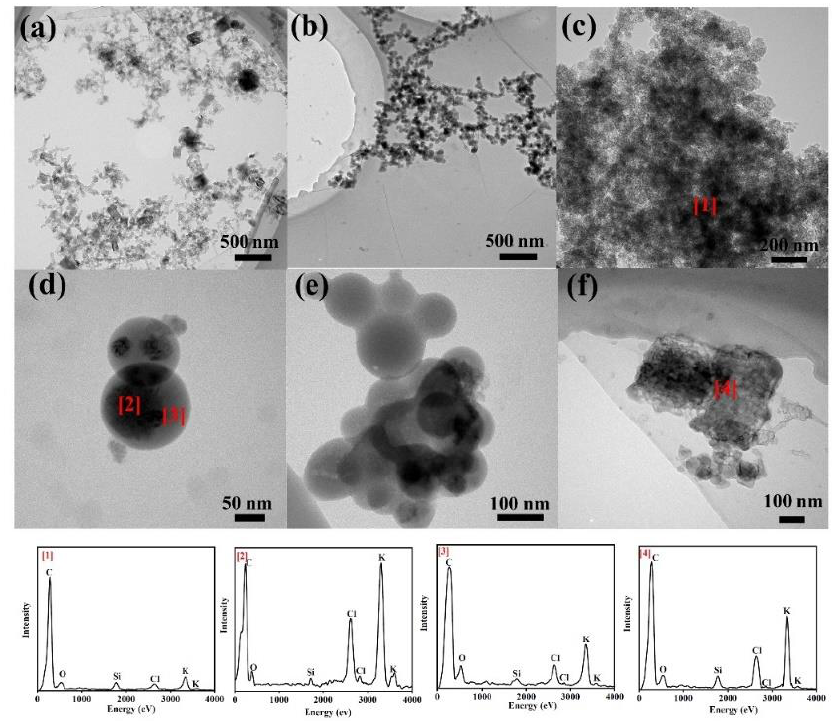
Figure 7. TEM images and EDS spectra of PM from the combustion of rice straw. ( a ) TEM images of multi-particle network morphology, ( b ) TEM images of chain-like morphology, ( c ) TEM images of soot morphology, ( d , e ) TEM images of individual particles, ( f ) TEM images of irregular particles. The corresponding EDS spectra are indicated by the number in square brackets.